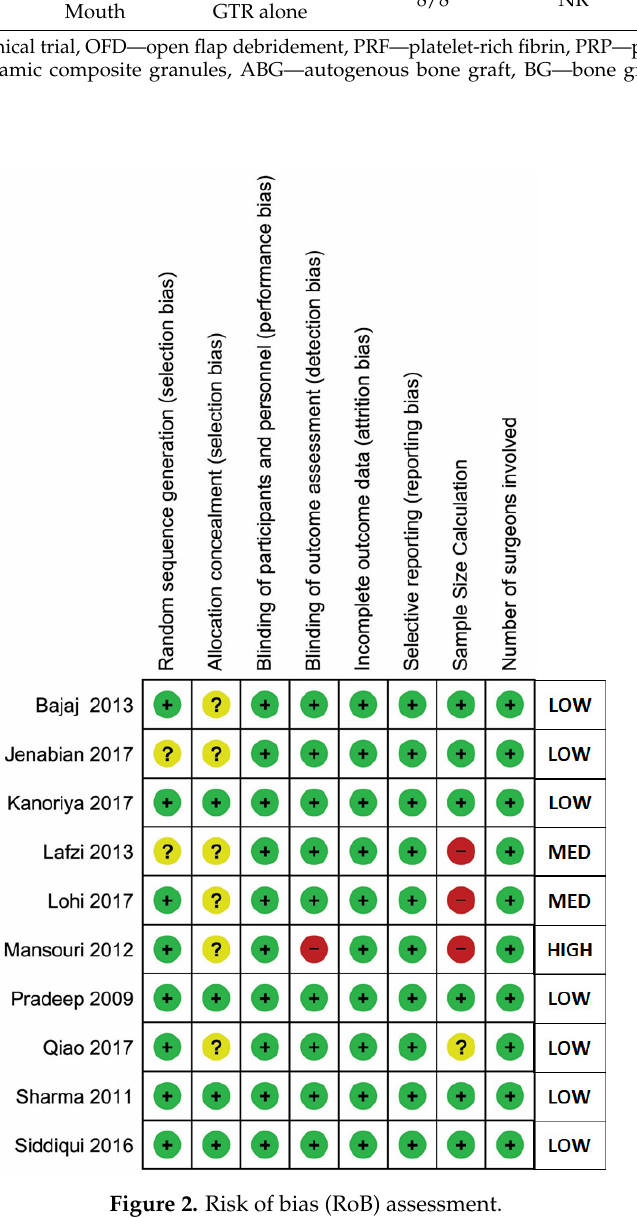
Figure 2. Risk of bias (RoB) assessment.